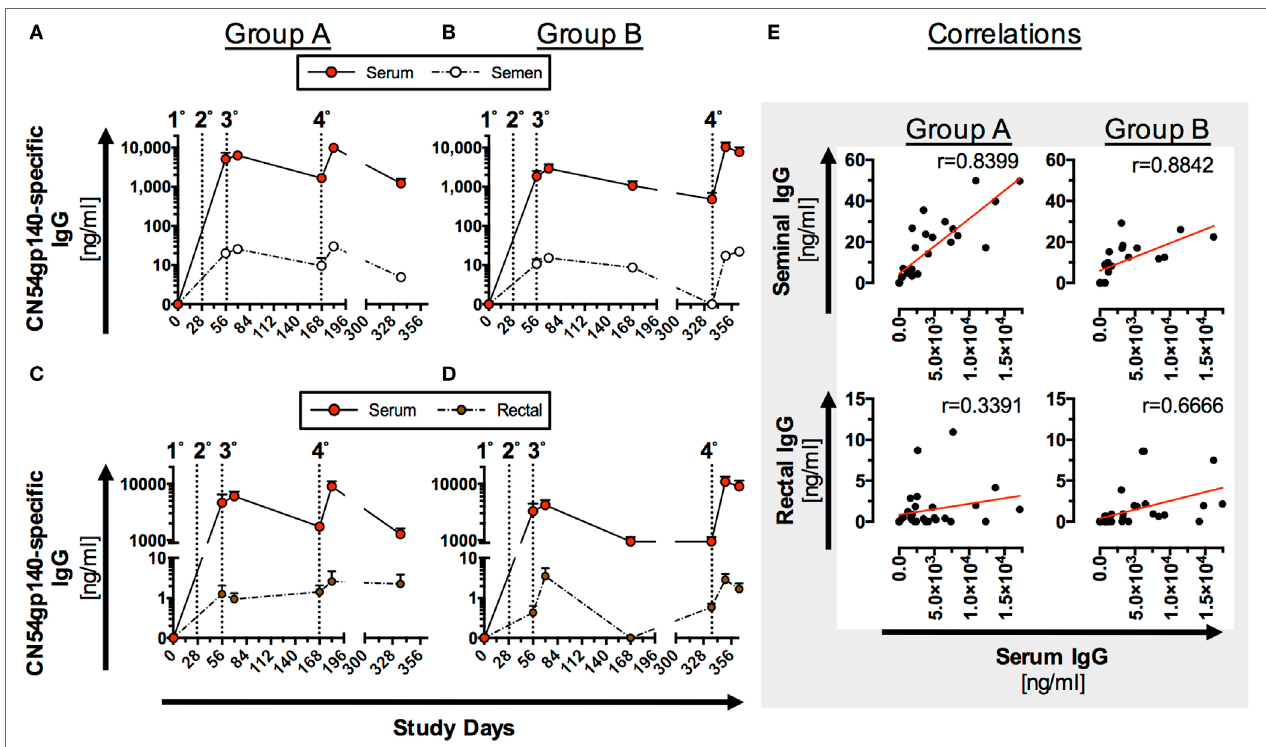
FiGUre 3 | antigen (ag)-specific humoral responses in seminal and rectal secretions following homologous prime-boost immunization (iM) . Participants received 3 × priming IMs of CN54gp140 adjuvanted with GLA-AF on days 0, 28, and 56, followed by a booster injection at day 168 (Group A) or day 336 (Group B); indicated by dotted line and numbers 1°–4°. (a–D) CN54gp140-specific IgG was measured in human serum/plasma, seminal ( n = 8) and rectal secretions ( n = 11) and expressed as mean ± SEM. (e) Ag-specific IgG levels in seminal secretions correlate significantly with systemic IgG in both groups, while correlation coefficients ( r -values) were lower when comparing Ag-specific IgG in rectal and systemic compartments. Spearman’s rank correlation coefficient ( p <